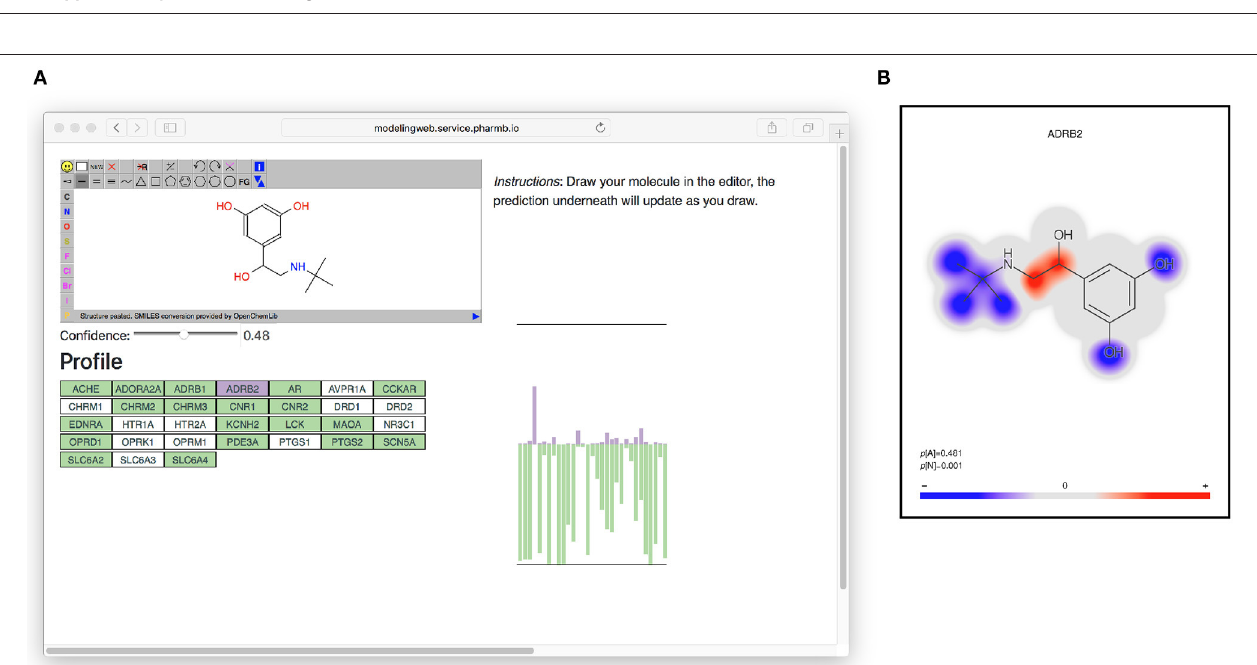
FIGURE 5 | Predicted vs. observed labels, for all targets, for the prediction data, at confidence level 0.8 (A) and 0.9 (B) . “A” denotes active compounds, and “N” denotes non-active compounds. The x-axis show observed labels (as found in ExCAPE-DB), while the y-axis show the set of predicted labels. The areas of the circles are proportional to the number of SAR data points for each observed label/predicted label combination. For predicted vs. observed labels for each target individually, see Supplementary Data Sheet 1 , Figures S2 , S3 .